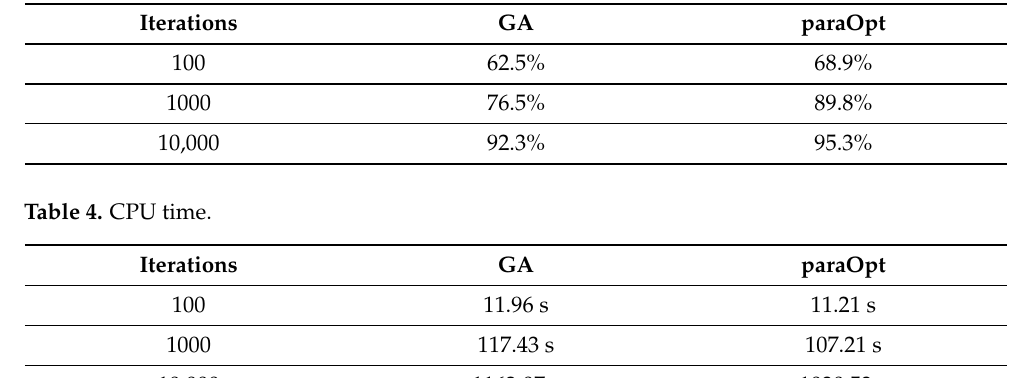
Table 3. Comparison between GA and ParaOpt .